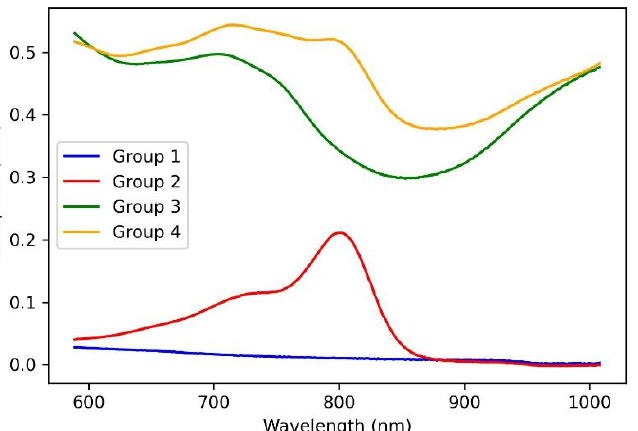
Figure 4. Absorption spectra of solders based on BSA (group 1), BSA+ICG (group 2), BSA+SWCNT (group 3), BSA+ICG+SWCNT (group 4).